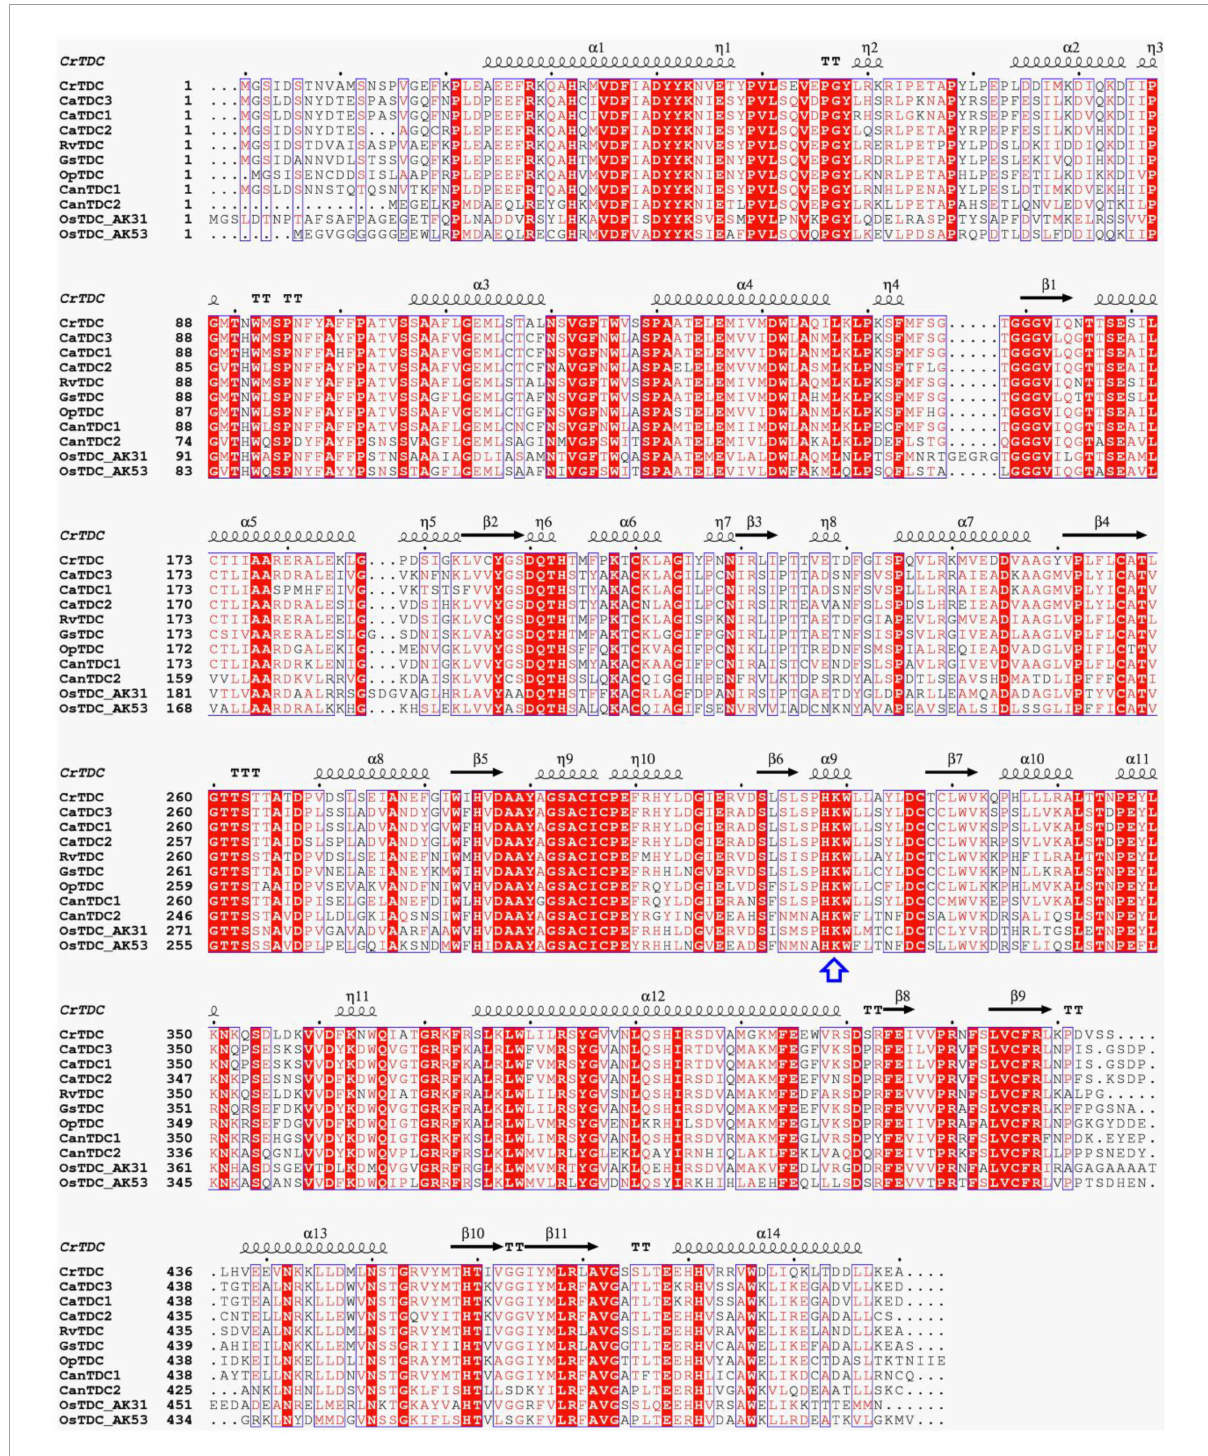
FIGURE3 Multiple amino acid residue sequences alignment of biochemically characterized plant TDCs. The key lysine involved in interaction with PLP was highlighted with a blue arrow. TDCs are from Catharanthus roseus (CrTDC, AAA33109.1), Rauvolfia verticillata (RvTDC, ADL28270.1), Gelsemium sempervirens (GsTDC, AXK92562.1), Ophiorrhiza pumila (OpTDC, BAC41515.1), Capsicum annuum (CanTDC1, ACN62127.1; CanTDC2, ACN62126.1), Oryza sativa Japonica Group (OsTDC_AK31, BAG91223.1; OsTDC_AK53, BAG95977.1), and Camptotheca acuminata (CaTDC1, AAB39708.1; CaTDC2, AAB39709.1). The results were graphed by using ESPript